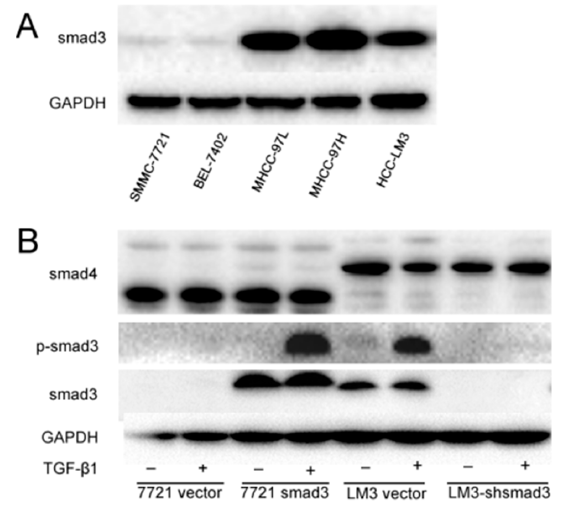
Figure 1. Transforming growth factor- β (TGF- β ) signaling is intact in smad3-expressing heptocelluar carcinoma (HCC) cells. ( A ) The expression of smad3 in HCC cell lines was detected by Western blot; ( B ) Stable overexpression of smad3 in SMMC-7721 cells and knockdown of smad3 in HCC-LM3 cells were confirmed by Western blot. Smad3 phosphorylation was activated upon TGF- β treatment in smad3-expressing cells. All of the experiments were performed three times and representative pictures are shown.